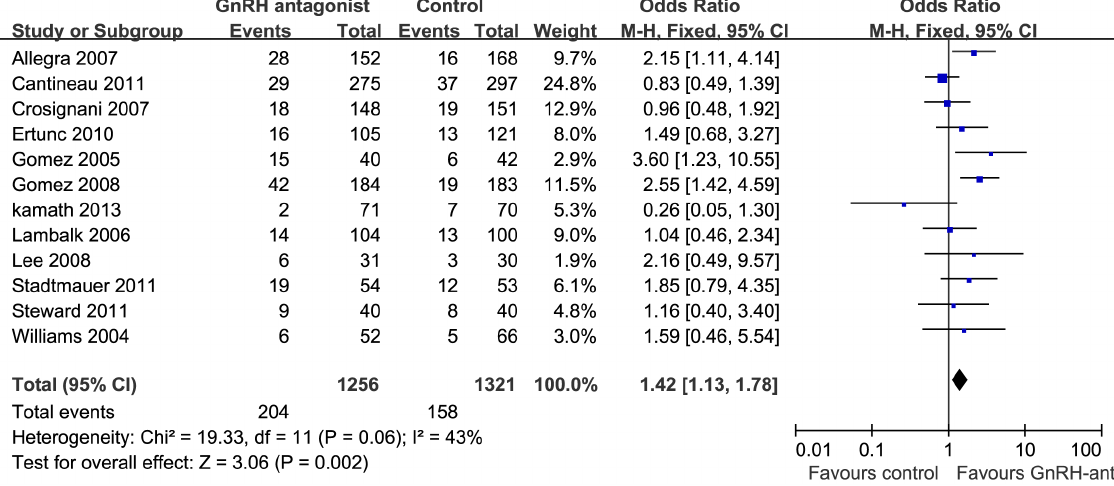
Figure 2. Forest plot of odds ratios (ORs) and 95% confidence interval (CI) of pooled trials comparing GnRH antagonist and control for clinical pregnancy